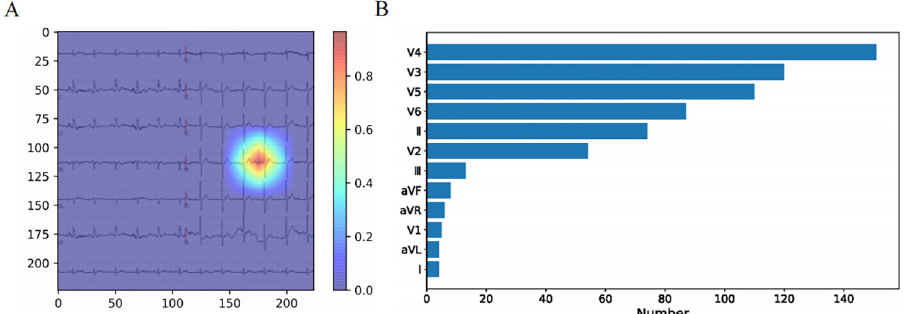
Fig 5. Grad-CAM feature visualization. (A) The example heatmap highlights the intensity of feature extraction from the original ECG, which reflects degrees of abnormality in various regions with respect to the N-N image. Regions with values greater than 0.8 are assumed to be key points in anomaly feature identification. (B) Among all important regions, the V3, V4, and V5 leads harbor most of the key points, and the V4 lead in particular serves as the most important factor in abnormal feature